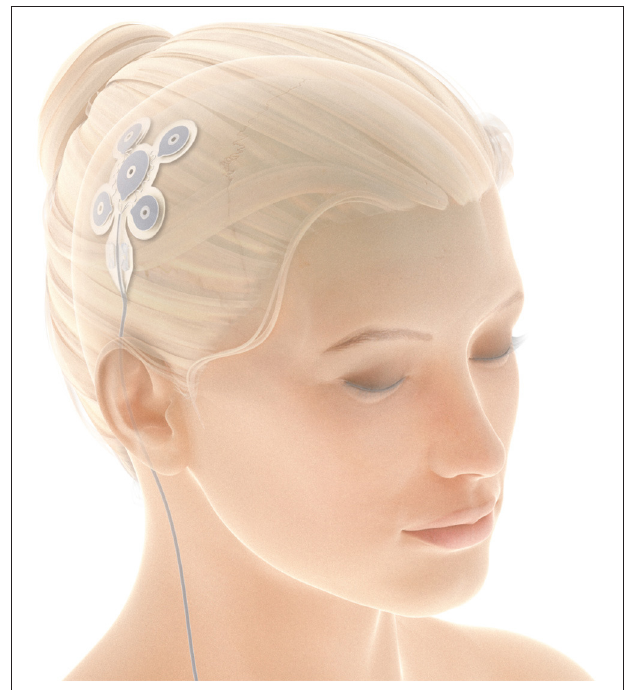
FIGURE 1 | A minimally invasive electrode setup as a part of an implantable system for focal epilepsy (Copyright © Precisis AG, Heidelberg, Germany).